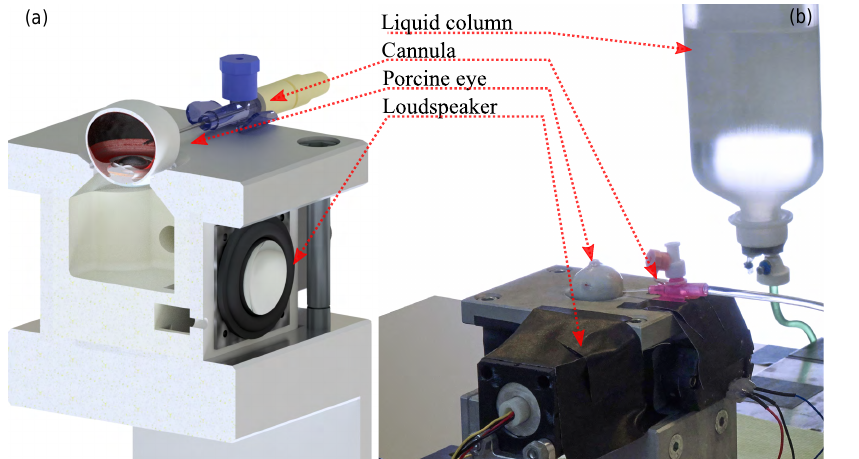
Figure 1. (a) Cross section of the measurement setup (CAD illustration) with the inside of the pressure chamber, a 30mm loudspeaker, and a model of a porcine eye connected by a cannula. (b) Laboratory experiments with a freshly enucleated porcine eye and a liquid column for pressure application. The diaphragm movement of the loudspeaker is detected by an infrared reflection sensor represented by CNY70 in front of